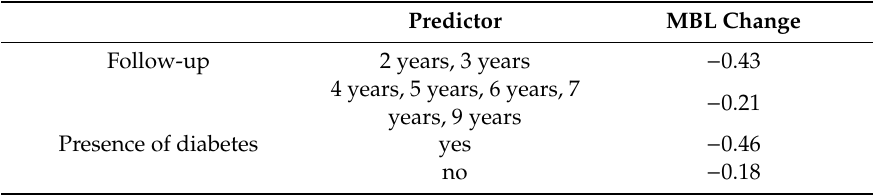
Table 8. Estimated MBL change (mm) according to years of follow-up and presence of